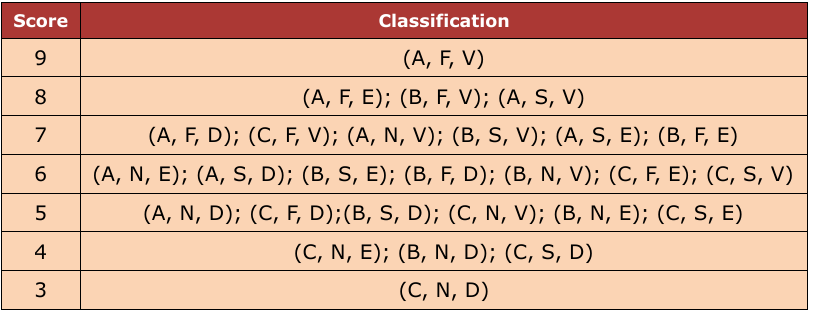
Table 3. Identical priority levels for all three